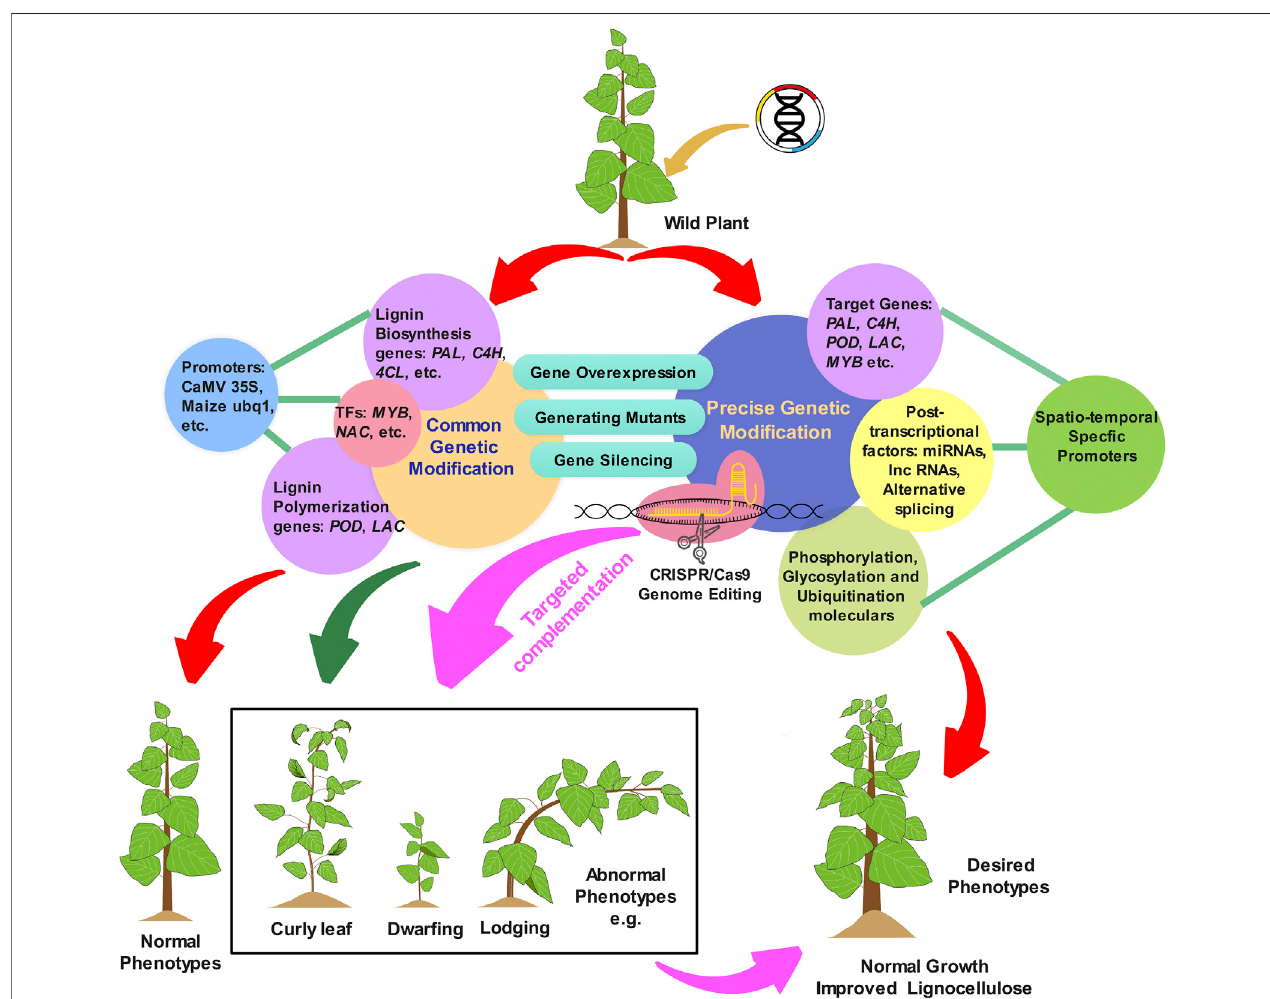
FIGURE2| Schematicillustrationshowcasingstrategiesforligninmodi fi cationsinplants.Conventionalapproaches,includinggeneticmodi fi cationofligninthrough overexpression, silencing, or knockout of core or non-core lignin biosynthetic genes under constitutive promoters, often lead to undesirable phenotypes, such as lodging, dwar fi ng, and leaf curling. Precision genetic modi fi cation approaches utiliziong spatio-temporal speci fi c promoters and post-transcriptional regulators have shown promise for overcoming the adverse side-effects of conventional approaches. CRISPR/Cas9 based genome editing technique are also anticipated to offer more fl exibility in targeted engineering of ligni fi cation patterns in